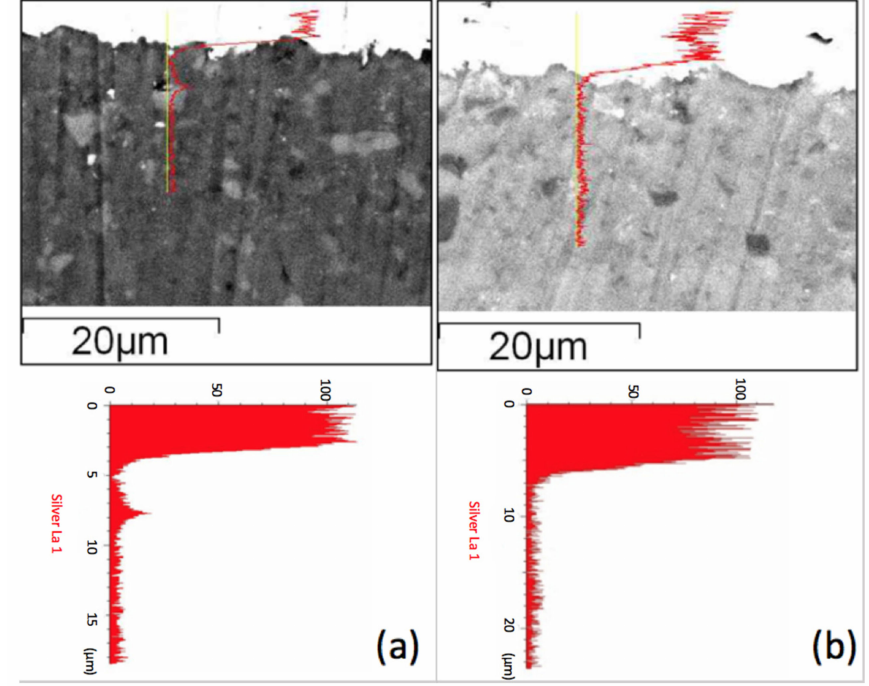
Figure 5. SEM micrograph and EDS curve showing silver distribution in modified CaO-MgO-2SiO 2 system with ( a ) 8 wt % (Zn 0.6 Mg 0.4 ) 2 SiO 4 ceramics; ( b ) 4% SiO 2